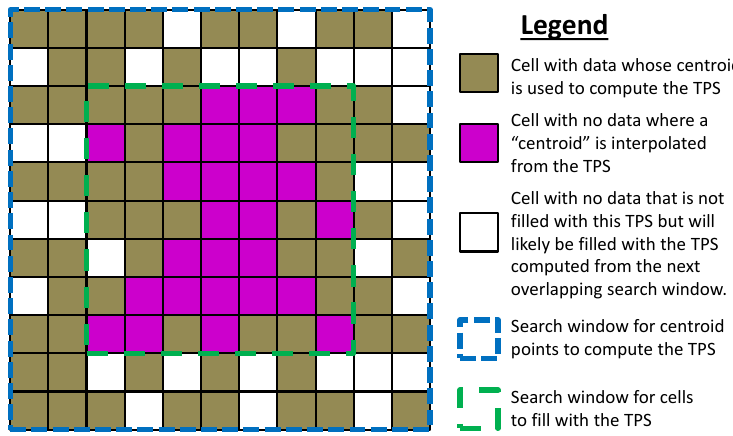
Figure 5. Schematic illustrating the hole filling process using thin plate spline (TPS)